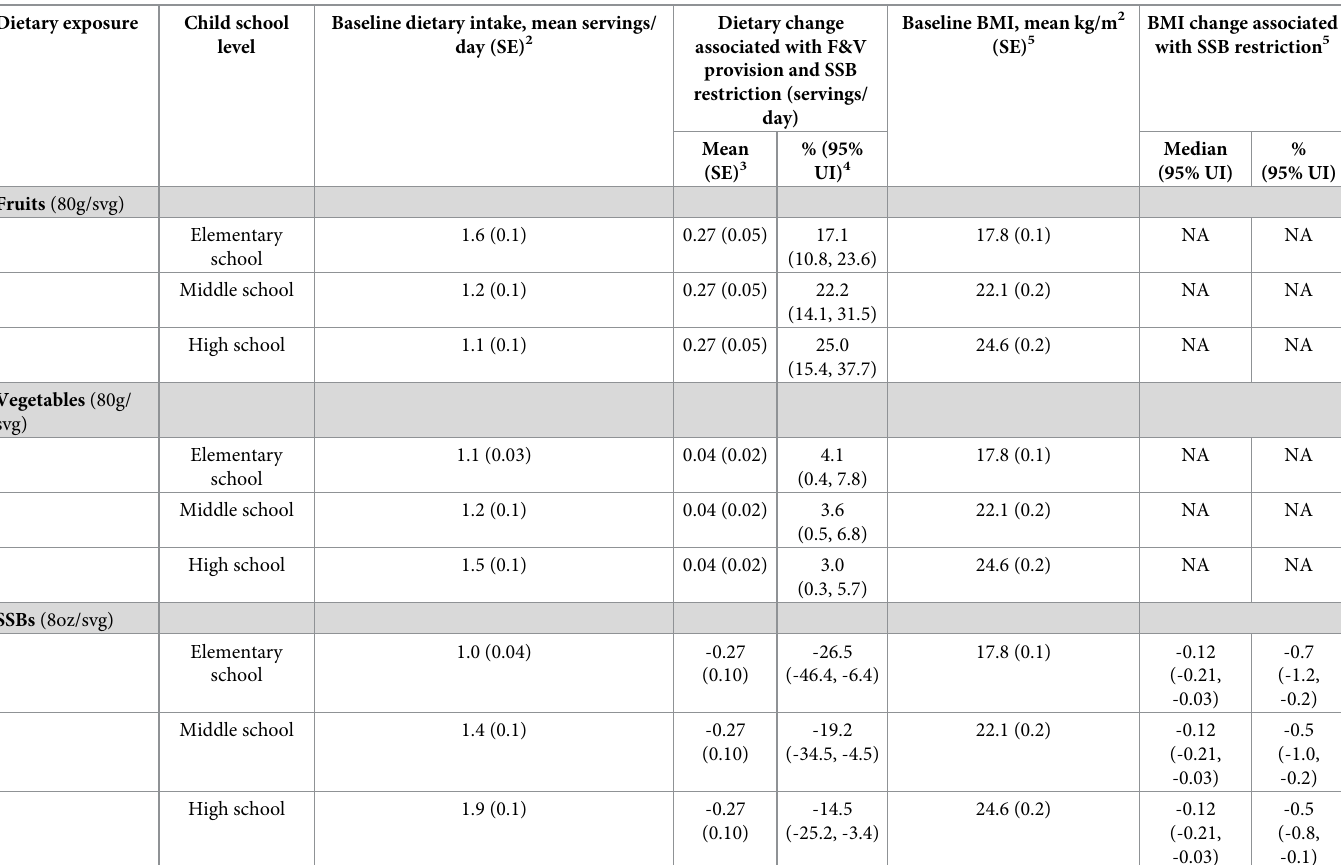
Table 1. Select model inputs and estimated changes in child diet and child BMI associated with F&V provision and SSB restriction in US schools 1 . Dietary